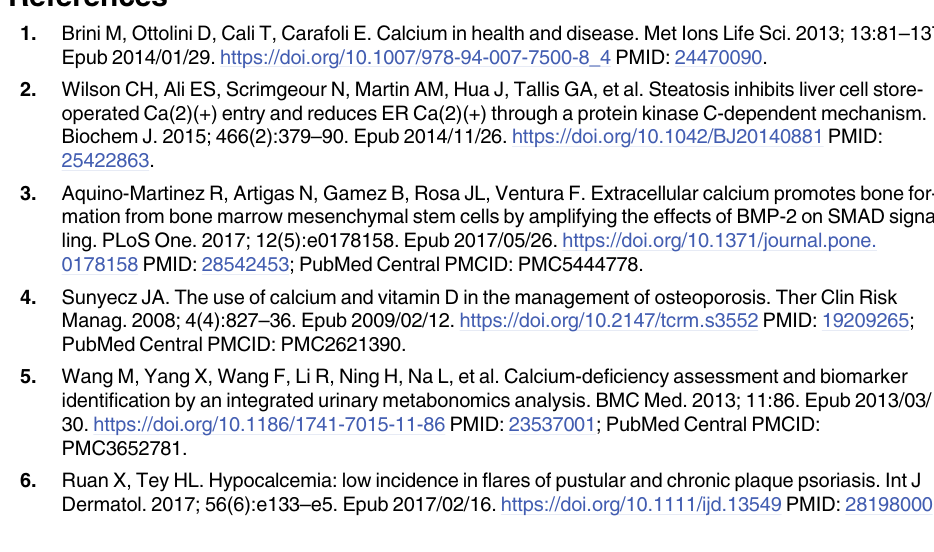
S1 Fig. Effect of calcium glucoheptonate on apoptotic proteins. MG-63 cells were treated with 0.25 and 1.0 mM concentrations of calcium glucoheptonate. Results indicated that no apoptosis was observed upon treatment. Hydrogen peroxide treated cells were used as positive